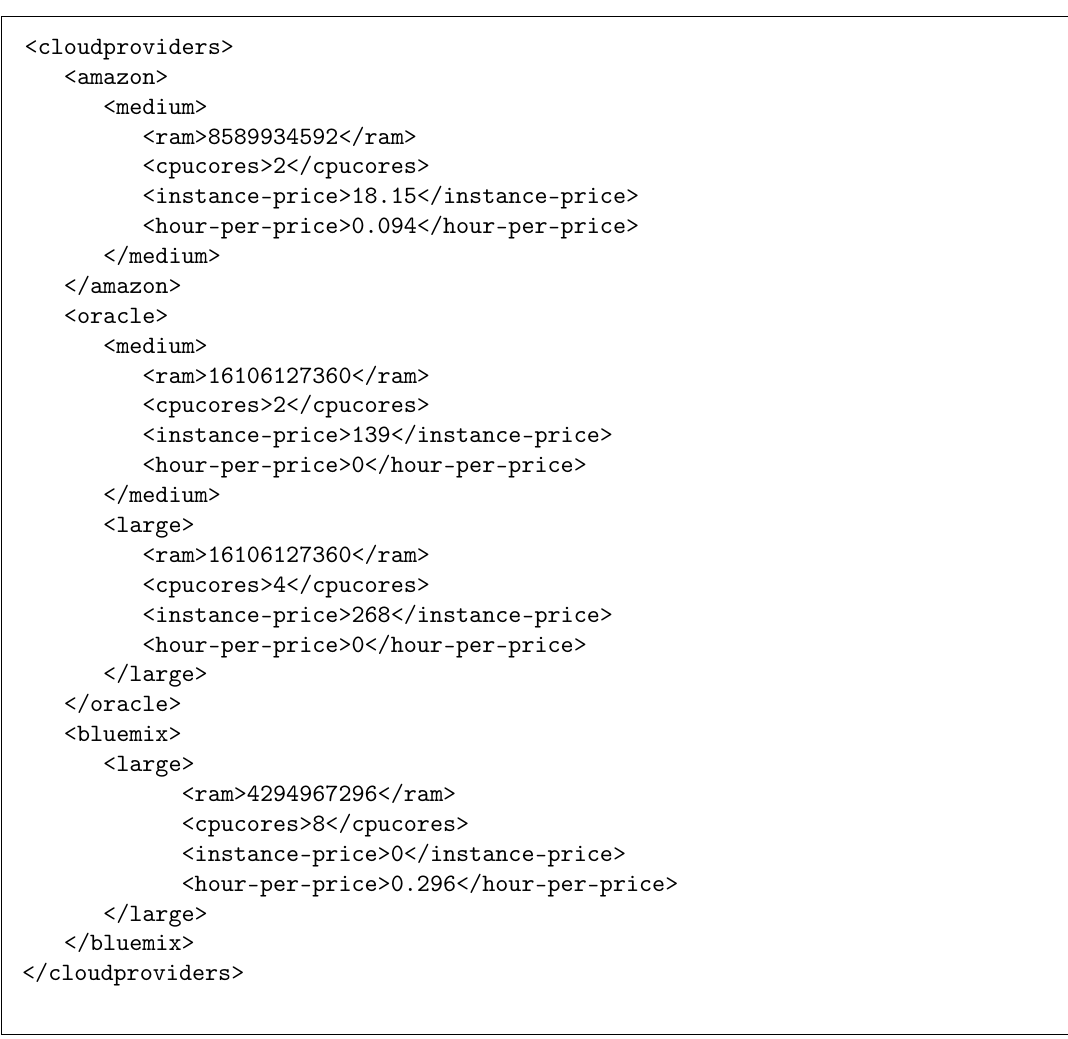
Figure 3. COST model of Cloud